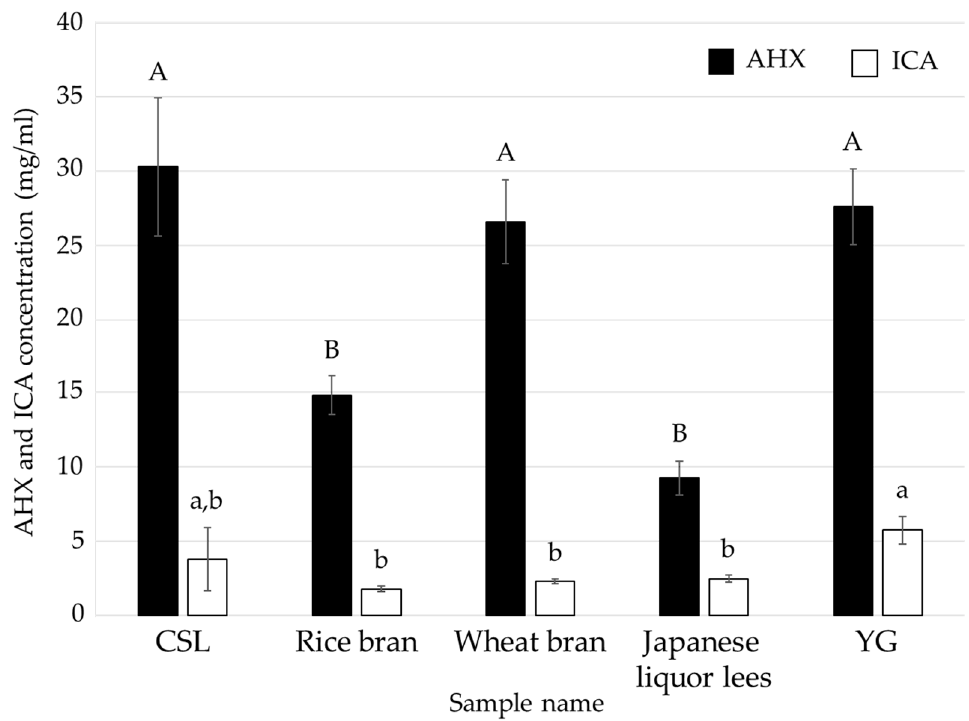
Figure 2. AHX and ICA contents of the culture filtrates of L. sordida mycelia cultured in media containing a food industrial by-product or YG. Different alphabet letters (capital letters for AHX, and small letters for ICA) indicate significant differences (Tukey–Kramer post hoc test, p < 0.05; n = 3).